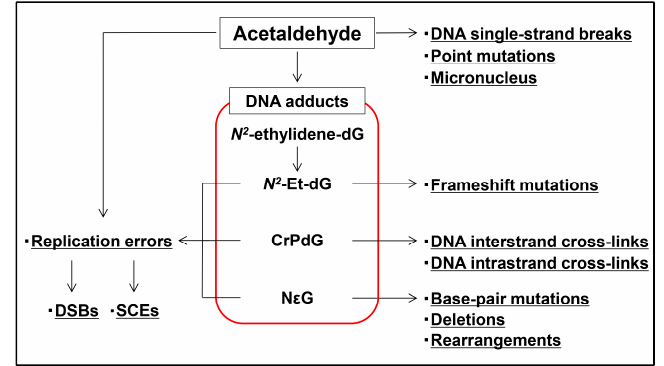
Figure 4. Summary of acetaldehyde-mediated DNA damage. Acetaldehyde causes DNA adducts, DNA single-strand breaks, DNA double-strand breaks (DSBs), point mutations, micronuclei, frameshift mutations, base-pair mutations, deletions, DNA–DNA interstrand or intrastrand cross-links, rearrangements, and sister chromatid exchanges (SCEs). DNA adducts are considered to be partly (but deeply) involved in their